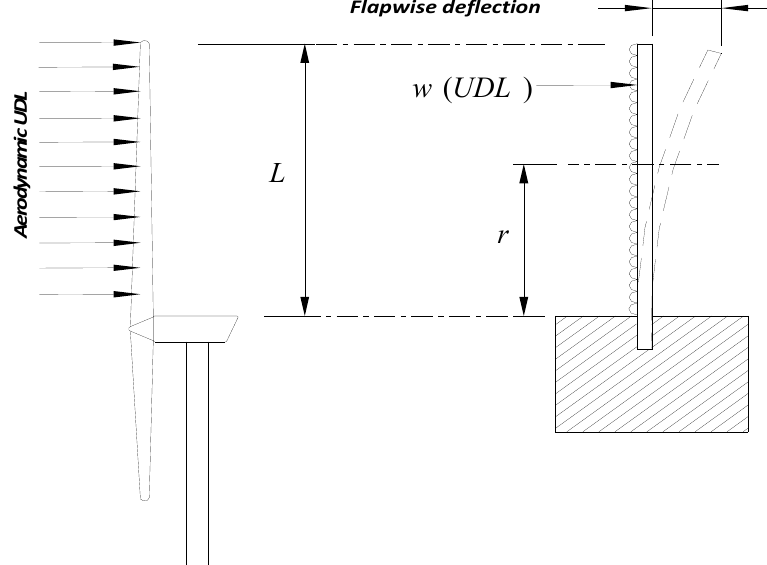
Figure 10. The blade modelled as a cantilever beam with uniformly distributed aerodynamic